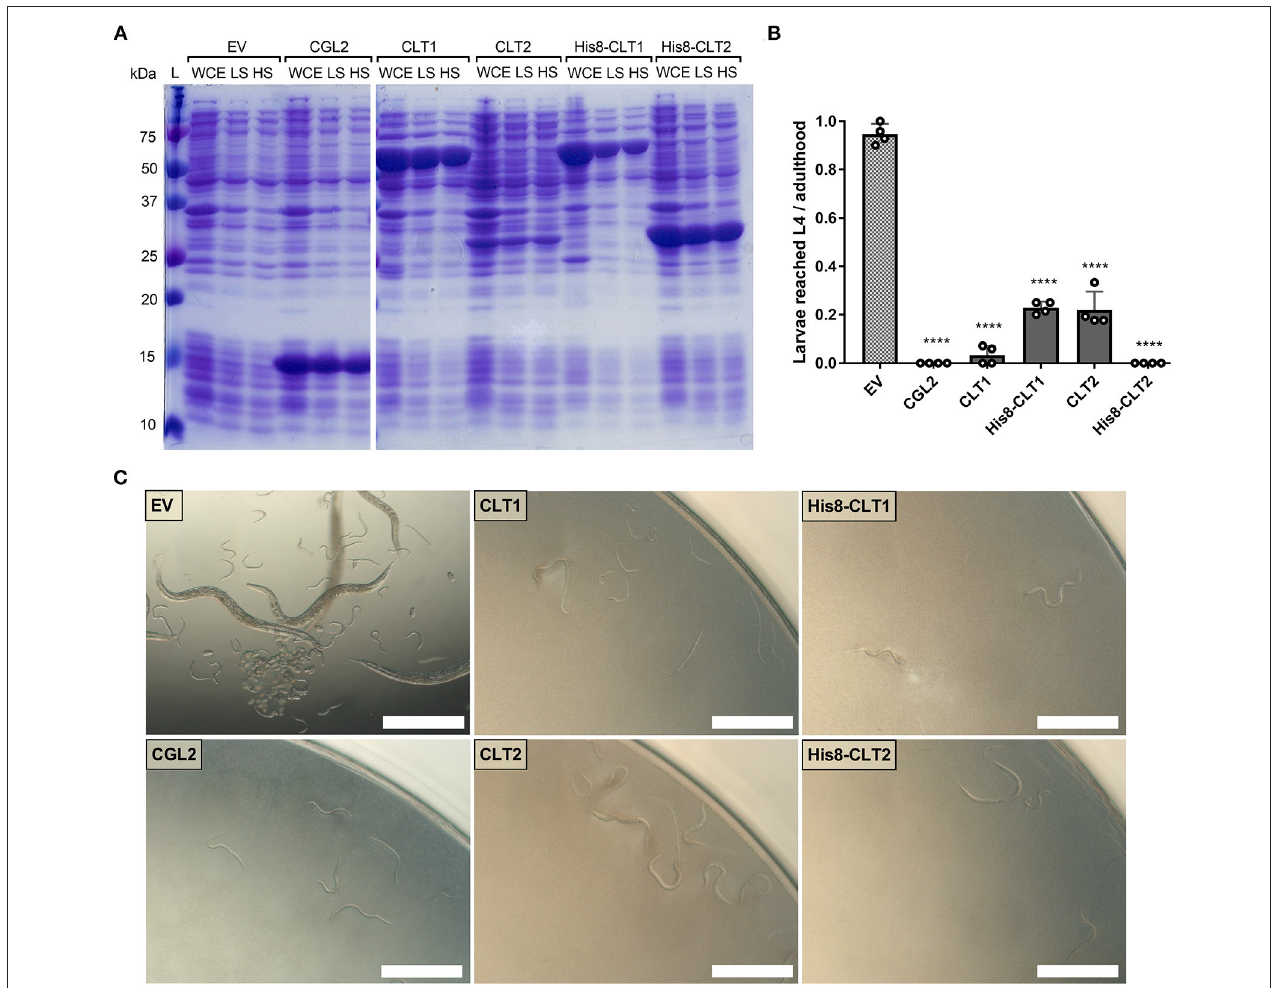
FIGURE 3 | CLT1 and CLT2 are nematotoxic proteins with predicted lipase domains. (A) Coomassie-stained SDS-PAGE showing heterologous expression and solubility of wild-type and His8-tagged CLT1 and CLT2 proteins. Twenty microliters of whole-cell extract (WCE) and supernatants of low-spin (LS; 5min. at 5,000g) and high-spin (HS; 30min. at 16,000g) bacterial lysate were loaded on a gel. CGL2 was used as a positive control and an “empty” vector (EV) was used as a background control for IPTG-induced expression and solubility. (B) Toxicity of untagged CLT1 and CLT2 as well as of their His8-tagged versions against C. elegans N2. IPTG-induced E. coli BL21 expressing previously characterized nematotoxic protein CGL2 and containing an “empty” vector (EV) were used as positive and negative controls, respectively. Dunnett’s multiple comparisons test was used for statistical analysis. Error bars represent the standard deviation of four biological replicates. * p < 0.05, ** p < 0.01, *** p < 0.001, **** p < 0.0001 vs. EV. (C) Phase-contrast micrographs of C. elegans fed with IPTG-induced E. coli BL21 for 72h expressing either of the indicated constructs. Scale bar = 500 µ